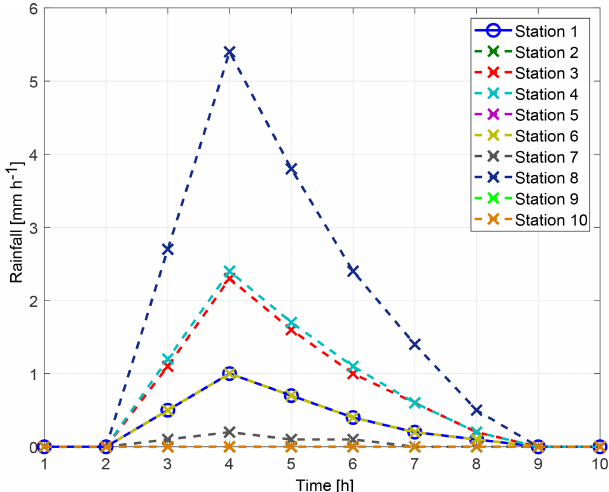
Figure 4. Time series of rainfall intensities at virtual monitoring stations.